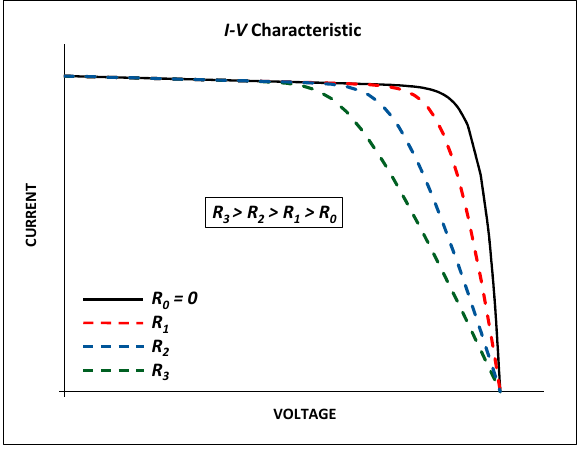
Figure 4. Effects of the series resistance on the I-V characteristic.